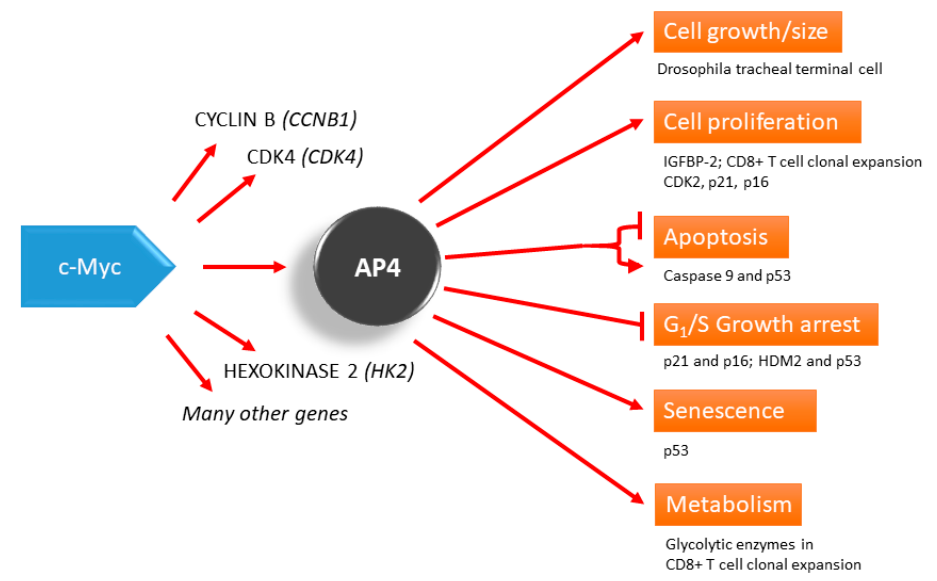
Figure 1. AP4 as a mediator of the c-Myc function. AP4 is involved in many processes, such as the control of cell proliferation, which may be a part of developmental programs, such as CD8+ T cell clonal expansion and Drosophila tracheal terminal cell branching. AP4 can also regulate apoptosis, growth arrest, and senescence, in which p53 seems to be an important downstream player. Evidence from siRNA knockdown experiments shows that AP4 represses apoptosis.